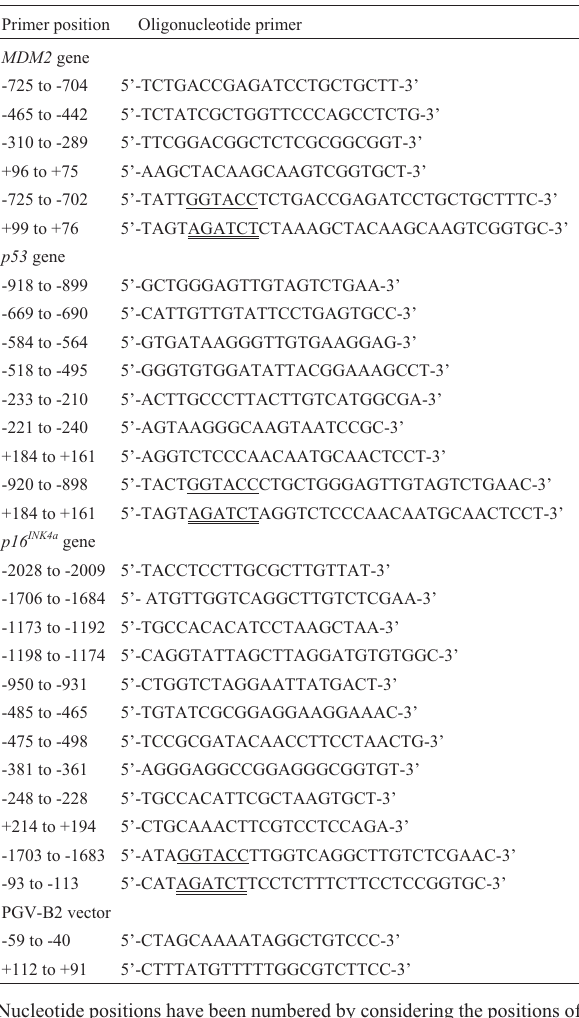
Table 1 - Primers used for PCR and